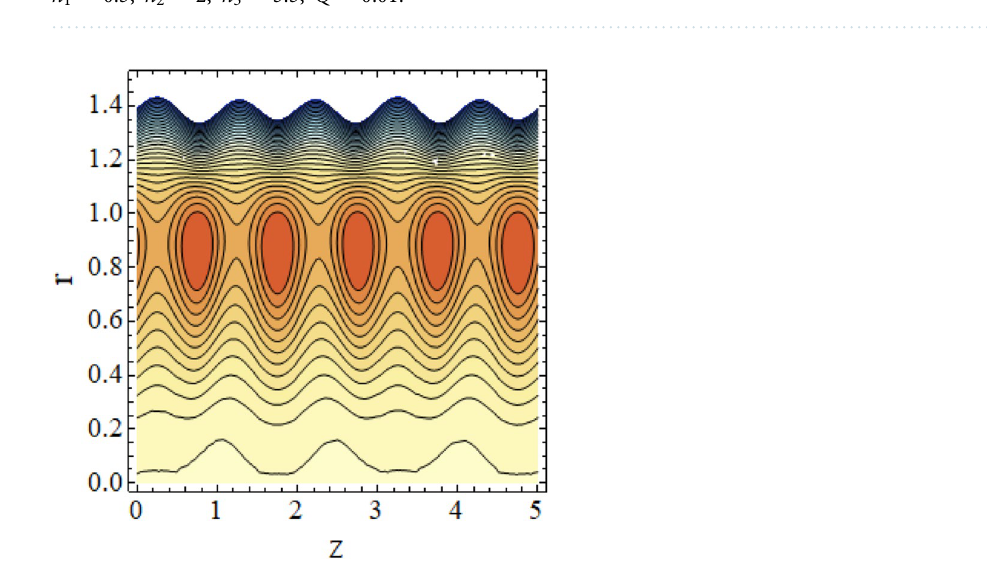
Figure 18. Streamlines for σ l = 0.05 with (cid:31) 1 = 0.4, φ = 0.037, a = 0.01, z d 1 = 0.5, z d 2 = 2, z d 3 = 3.5, h 1 = 0.5, h 2 = 2, h 3 = 3.5, Q =